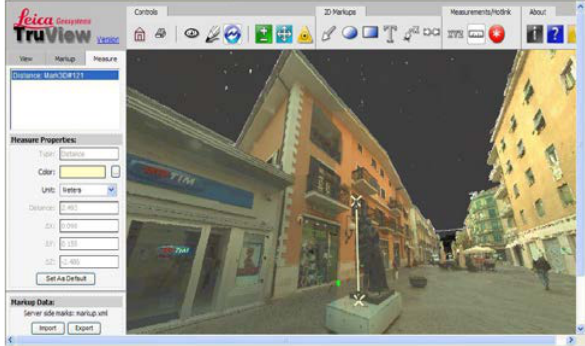
Figure 13. Screenshot of Trueview®